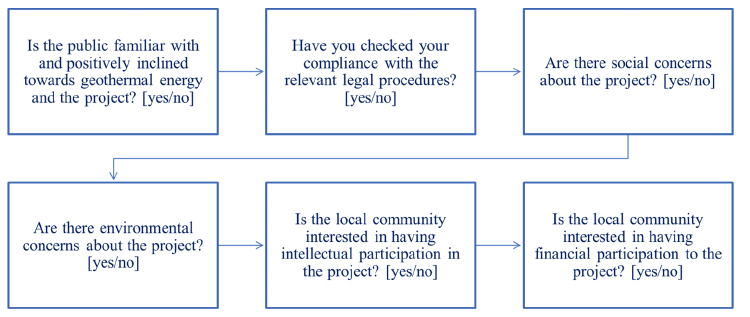
Figure 12. Decision tree’s sequence of questions to enhance public engagement.